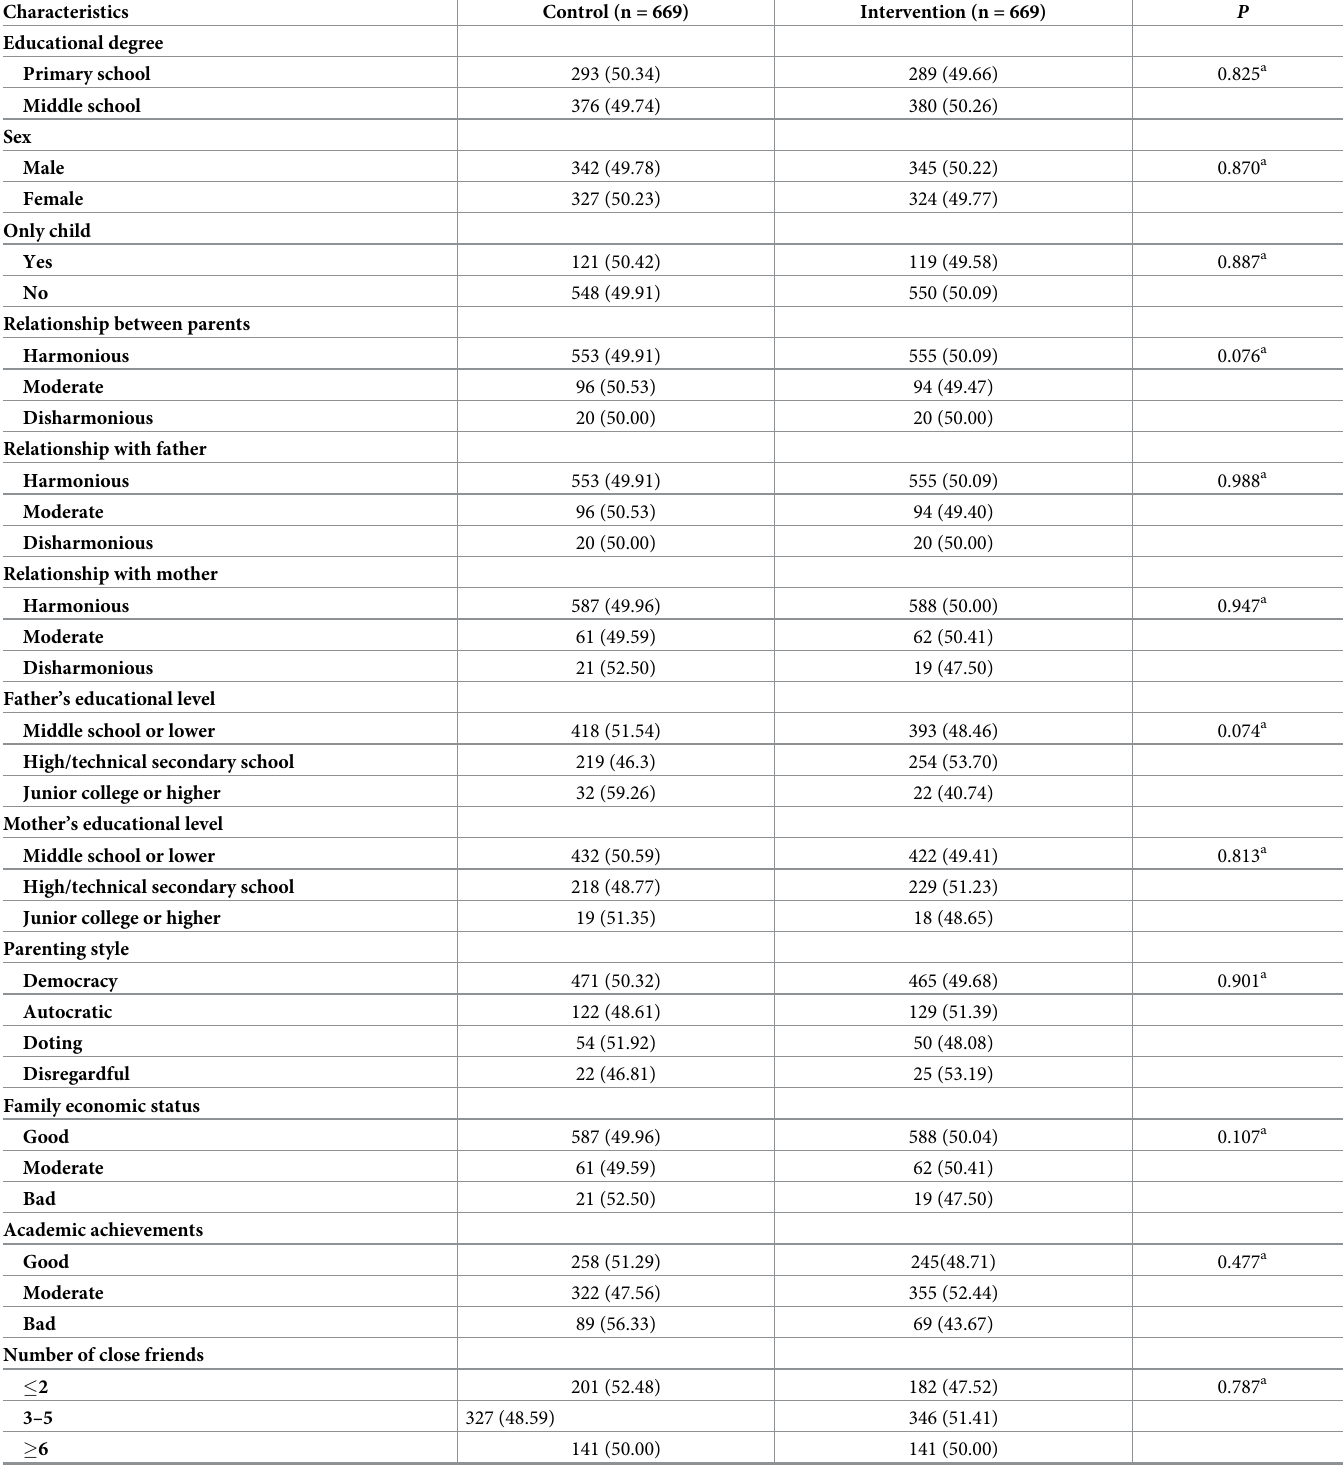
Table 2. Distribution of sociodemographic characteristics between intervention and control groups after PSM (n = 1,338).